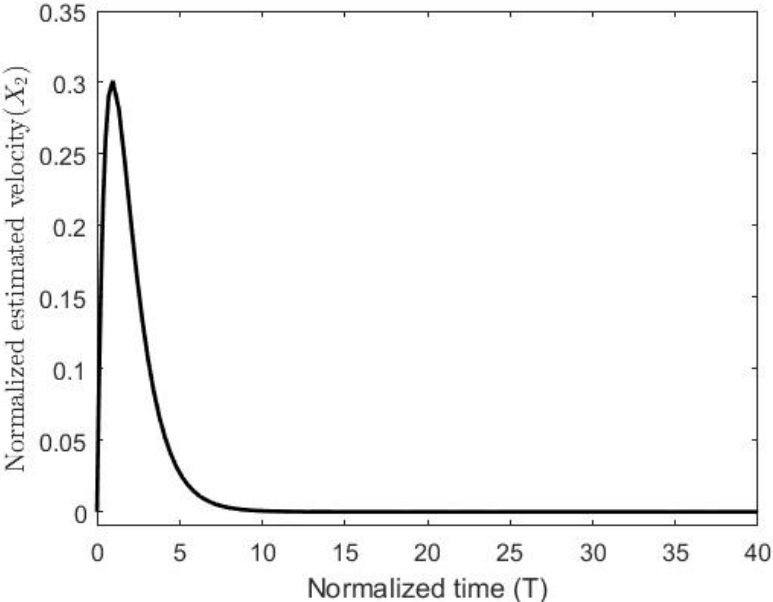
Figure 8. The normalized estimated velocity with the coupling constant at a gap distance of 0.8. The results for stabilization of the plate by varying the coupling term ( γ ) are shown in Figure 9.